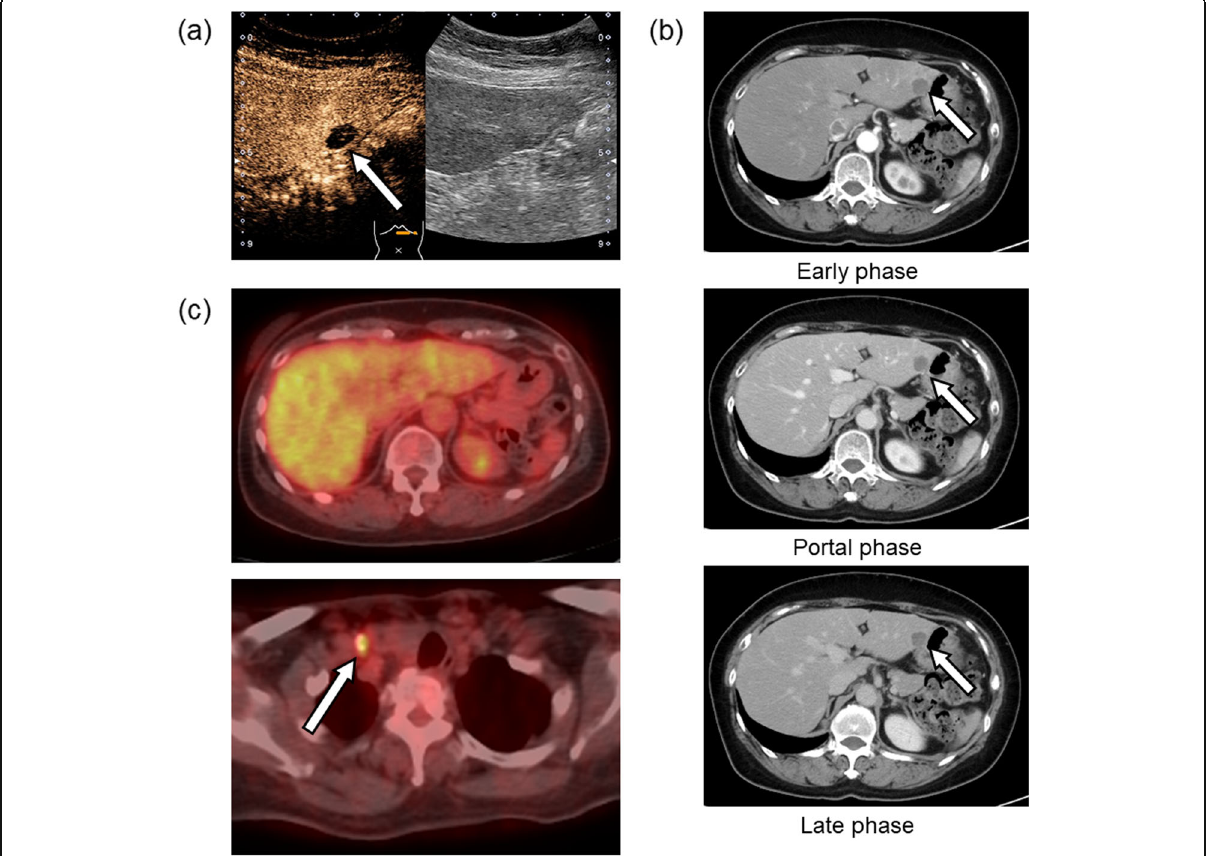
Fig. 1 a Abdominal contrast-enhanced ultrasonography shows a 16-mm echo-free mass in the lateral segment of the liver, which resulted in a defect in the Kupffer phase (arrow). b Enhanced abdominal computed tomography scan shows a 16-mm marginally enhanced tumor in the lateral segment of the liver (arrow). c Fluorodeoxyglucose positron emission tomography (FDG-PET) is negative for liver tumors. FDG uptake (maximal standardized uptake value = 3.43) is observed at the nodule outside the right lobe of the thyroid gland